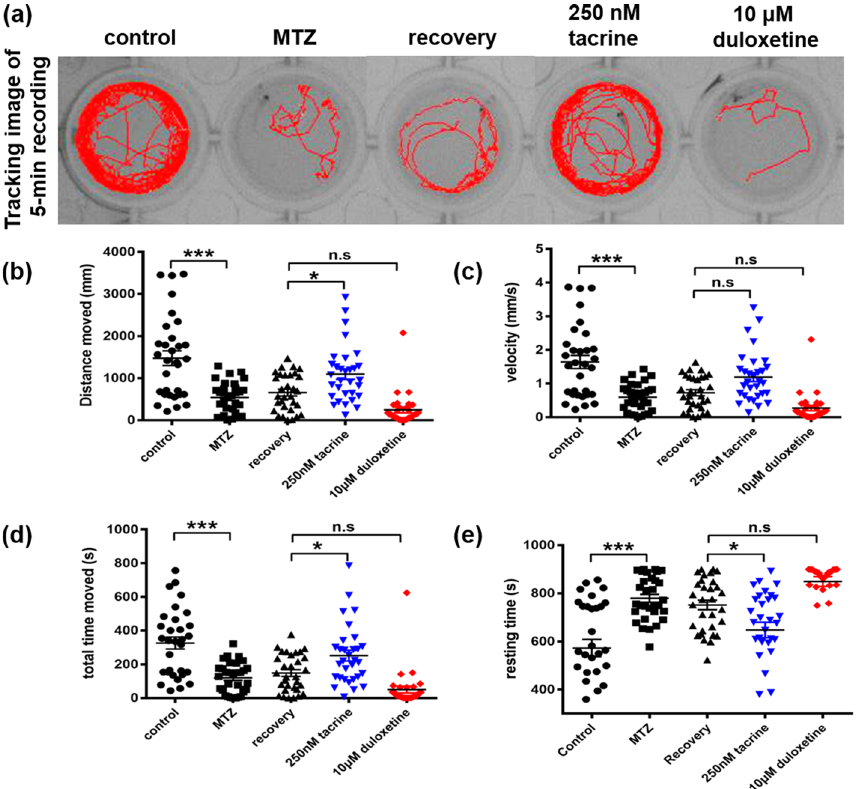
Figure 5. Tacrine, but not duloxetine, promotes restoration of locomotor activity. ( a ) Representative tracking image of a 5-min recording at 8 dpf. Quantification of ( b ) total distance moved (control: 1476.41 ± 975.90, MTZ: 539.10 ± 369.30, recovery: 655.05 ± 441.90, 250 nM tacrine: 1093.44 ± 670.50, 10 μM duloxetine: 243.87 ± 383.45), ( c ) velocity (control: 1.64 ± 1.09, MTZ: 0.60 ± 0.41, recovery: 0.73 ± 0.49, 250 nM tacrine: 1.19 ± 0.75, 10 μM duloxetine: 0.27 ± 0.42), ( d ) total movement time (control: 327.08 ± 200.34, MTZ: 120.81 ± 90.72, recovery: 148.80 ± 109.57, 250 nM tacrine: 252.45 ± 176.18, 10 μM duloxetine: 50.55 ± 113.43), and ( e ) total resting time (control: 572.91 ± 200.34, MTZ: 779.18 ± 90.72, recovery: 751.19 ± 109.57, 250 nM tacrine: 647.54 ± 176.18, 10 μM duloxetine: 549.44 ± 113.43) during 15-min recordings. The experiment was independently repeated three times (n = 31 per group). Error bars indicate mean ± standard deviation. *** p < 0.001; ** p < 0.01; * p < 0.05; n.s., not